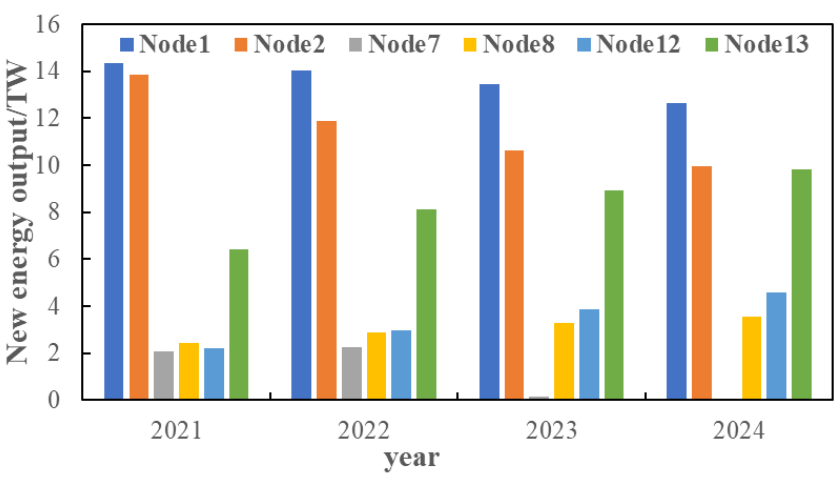
Figure 25. Power output of each power supply in the distribution network from 2020 to 2024.